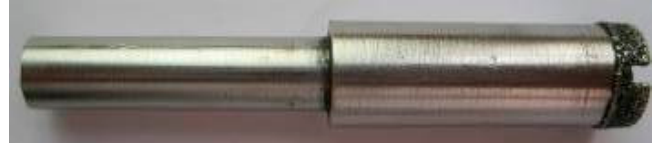
Figure 6. Cup-shaped sintered diamond grinding wheel.